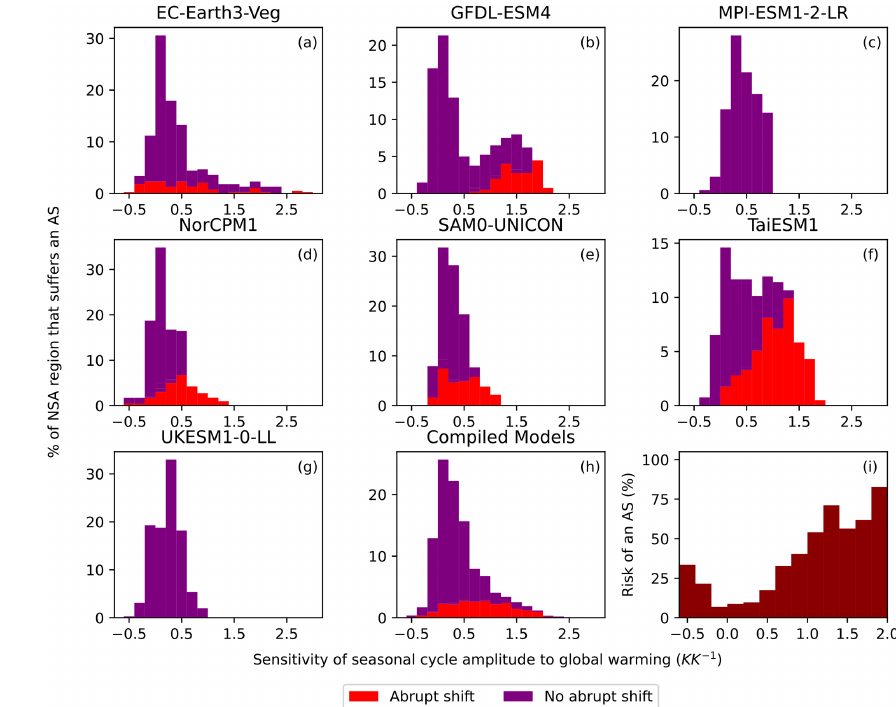
Figure 4. Plots demonstrating the efficacy of the temperature seasonal cycle amplitude as a method of assessing the risk of an oncoming abrupt dieback shift. (a–g) Histograms with bins of width 0.2 showing the percentage area of the NSA region that have different sensitivities of the temperature seasonal cycle amplitude to global warming, calculated up to a doubling of CO 2 . Red-coloured bars correspond to grid points with detected dieback shifts, and purple bars indicate grid points where no abrupt shifts are detected. (h) The mean of histograms (a) – (g) . (i) A bar chart showing how the percentage risk of a grid point, in any of the seven analysed models, experiencing a dieback shift changes with increasing sensitivity of the seasonal cycle amplitude to global